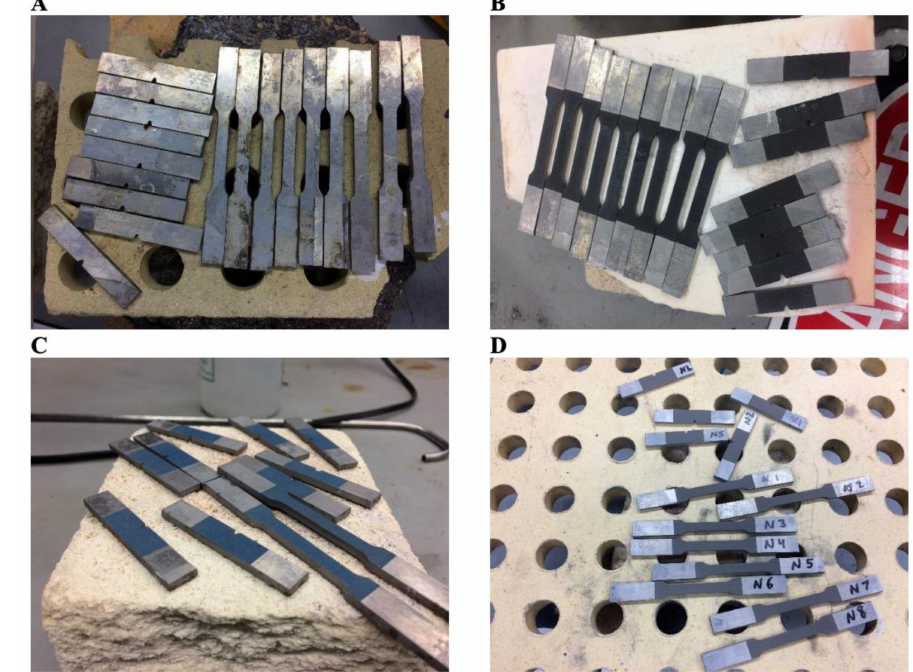
Figure 2. ( A ) Digital image of the thermally postprocessed HPDC A365 reference specimens procured during the current research effort. ( B ) Digital photo of the thermally postprocessed Cu CGDS coated HPDC A 365 substrate system. ( C ) Digital photo of the thermally postprocessed Ti CGDS coated HPDC A 365 substrate system. ( D ) Digital image of the thermally postprocessed Ni CGDS coated HPDC A 365 substrate system. Note that the same dimensional reference provided in Figure 1 holds here as